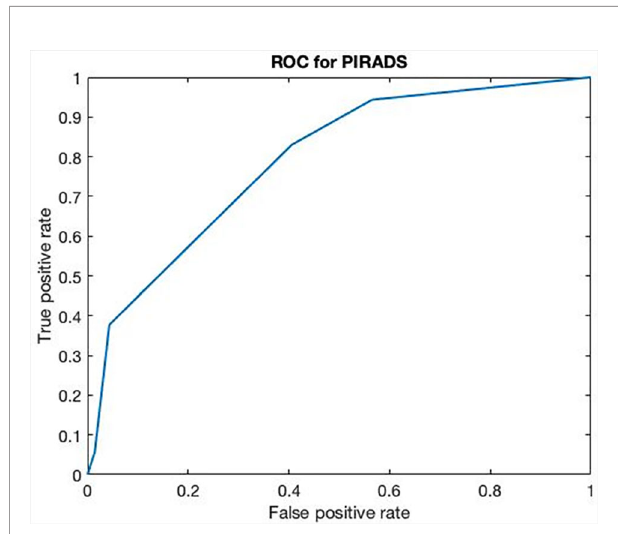
FIGURE 3 | ROC curve of multiparametric MRI. ROC curve of multiparametric MRI on 123 patients with clinical suspicion of PCa (AUC